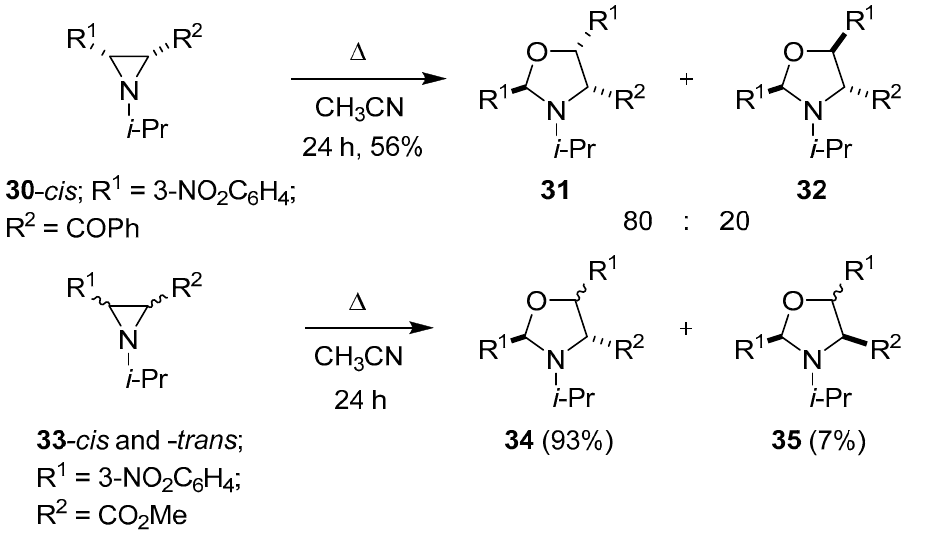
Table 4. Cycloaddition of azomethine ylide 37 to aromatic aldehydes 2a and 2i (Scheme 7). Scheme 6. The partial fragmentation/cycloaddition reactions of aziridines 30 and 33 .